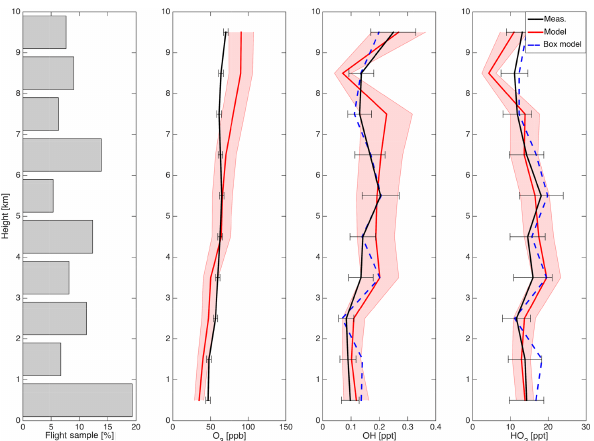
Figure 4. Vertical profiles of median modeled (red) and measured (black) ozone, OH, and HO 2 for Honolulu-based INTEX-B flight data binned by kilometer. Gray bar graph shows percent of flight data within each vertical bin. Shaded regions represent 1 σ of the model ensemble; error bars on measurements are uncertainty at 1 σ confidence. Blue line represents results from the box